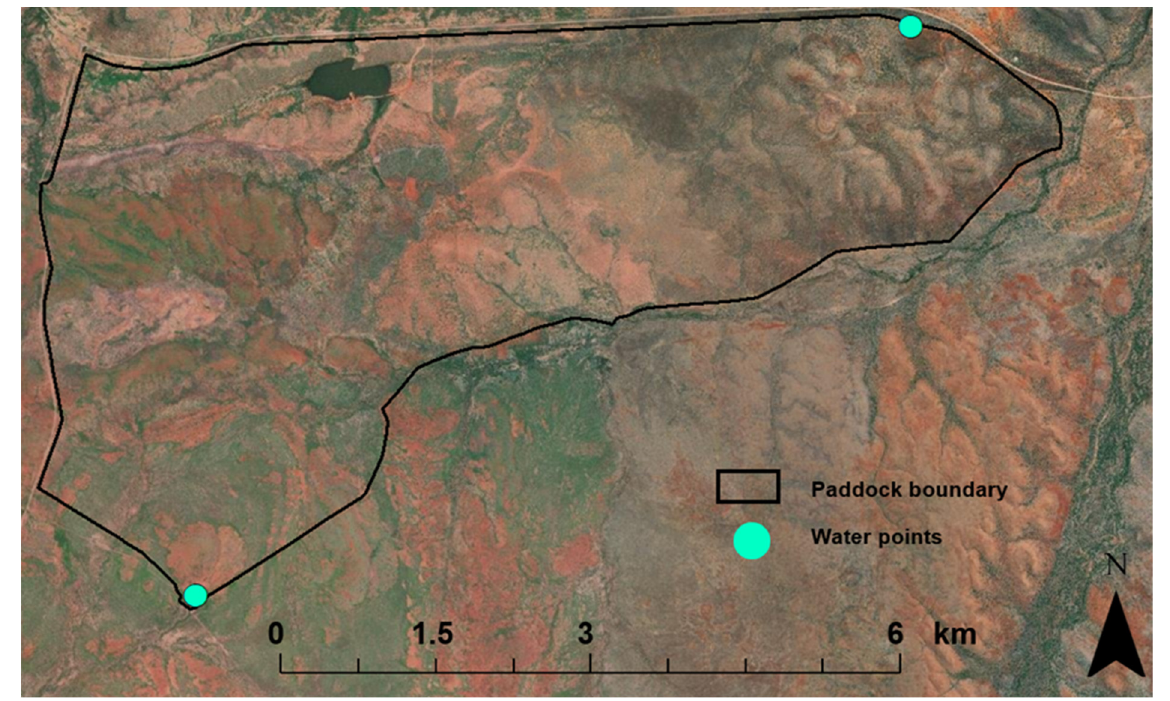
Figure 1. Satellite image of the trial paddock with water points displayed. Trial animals were able to access the dam on the northern boundary in Year 1, but not in Year 2.